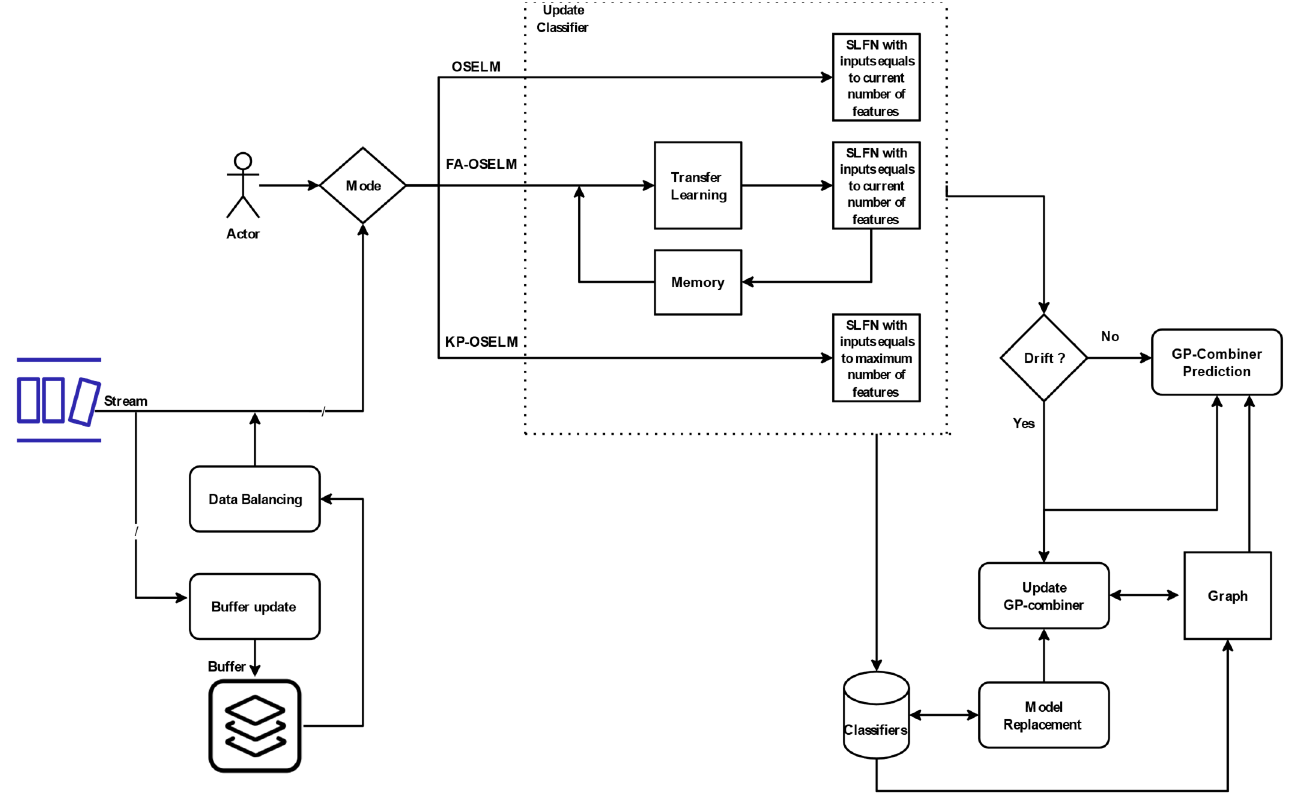
Figure 4. Framework of the incremental GPC using three modes: OSELM, FA-OSELM, and KA- OSELM.